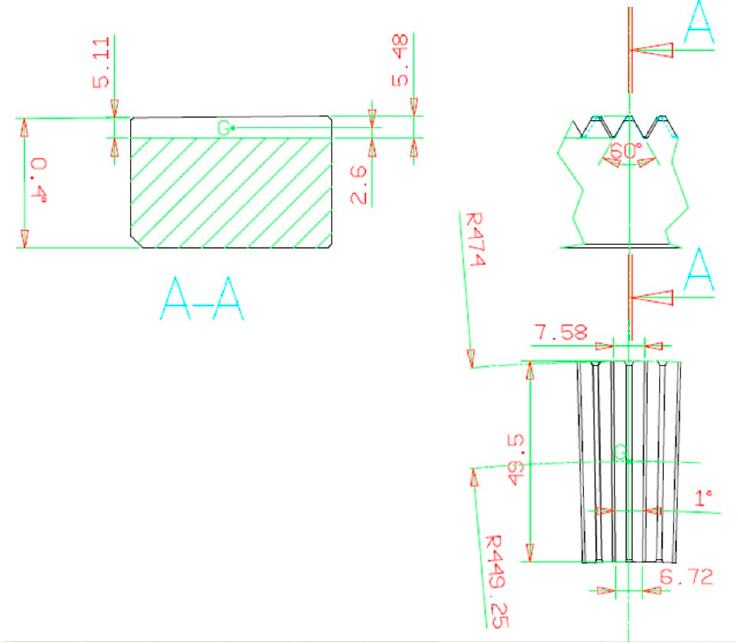
Figure 14. Tooth geometry for the case study.